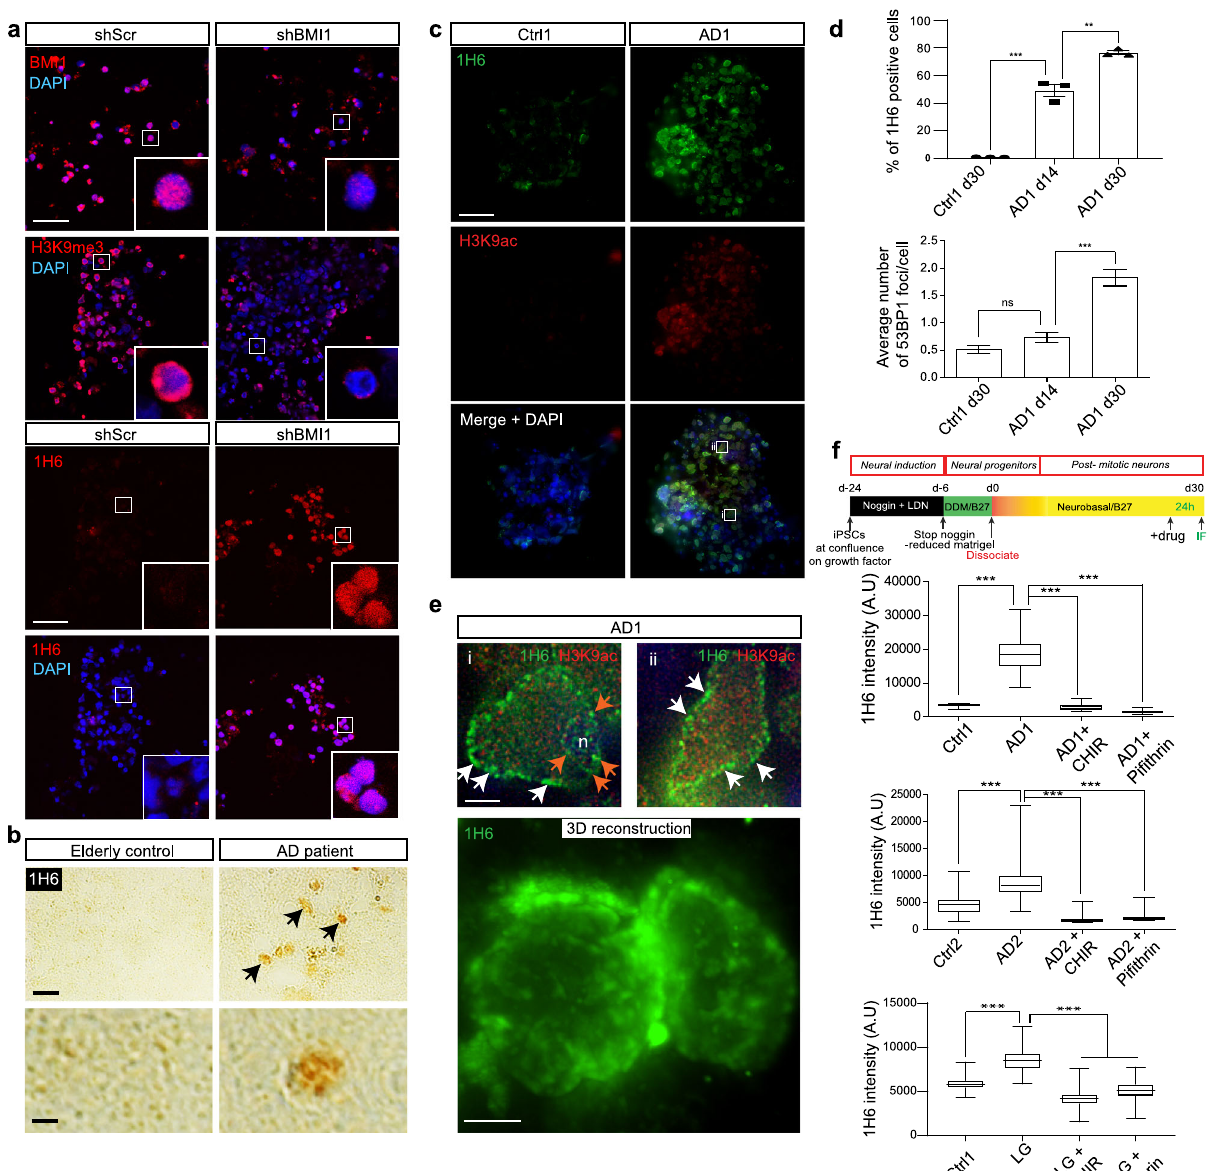
Fig. 2 Re-establishing chromatin compaction reverses accumulation of G4 structures in AD neurons. a IF analysis showing that BMI1 knockdown in human neurons differentiated from embryonic stem cells results in loss of heterochromatin (H3K9 me3 ) and induction of G4 DNA structures (1H6). Scale bar: 35 µ m. b IHC analysis on frozen human brain sections (hippocampus) showing 1H6 immunoreactivity in AD patient ’ s neurons. The frozen sections were from the hippocampus of end-stage disease (Braak stage V/VI) AD patients ( n = 3) and non-demented age-matched controls ( n = 3). The samples ’